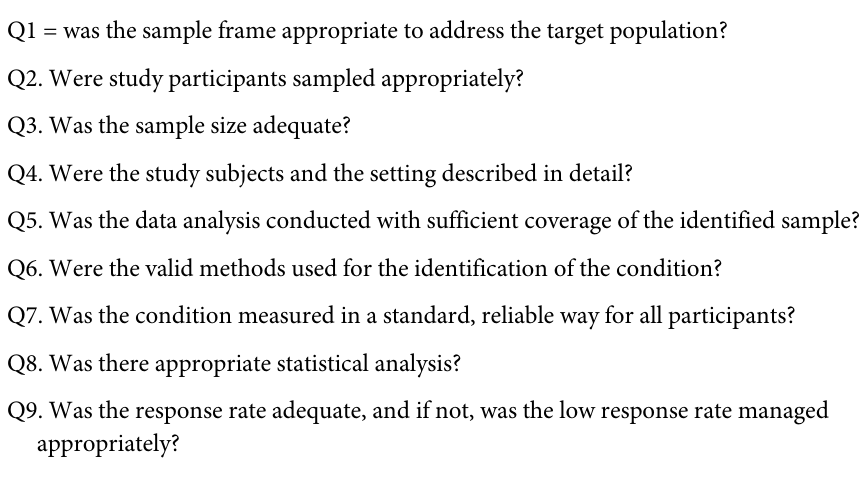
The methodological quality of included studies was appraised using a modified and predefined checklist to assess the methodological quality aspect quality of life among cancer patients reported.